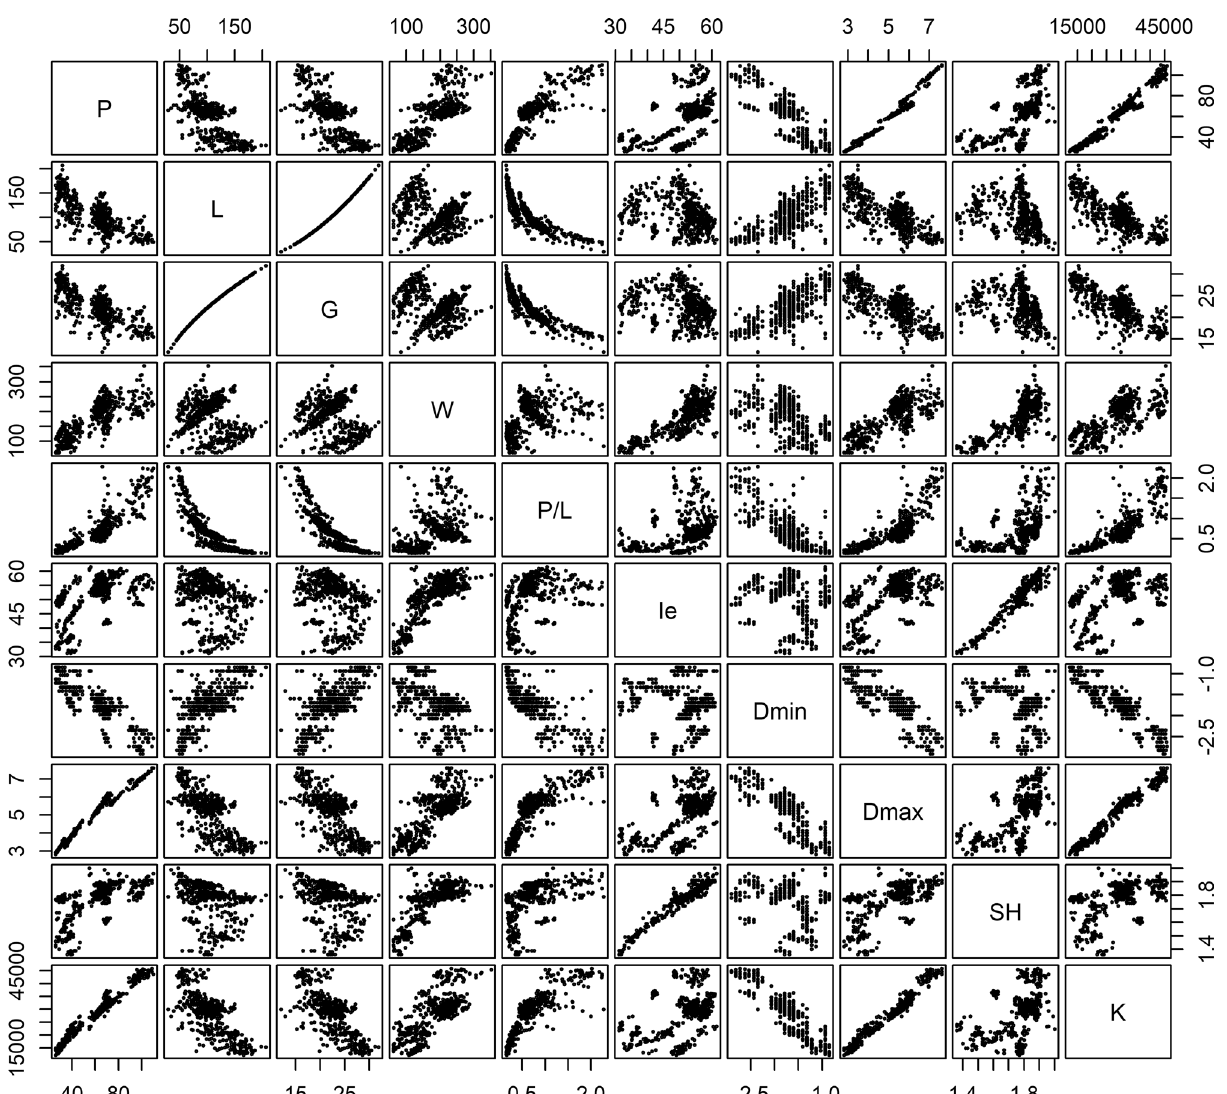
Figure 2. Scatter plot matrix between the different alveograph parameters.